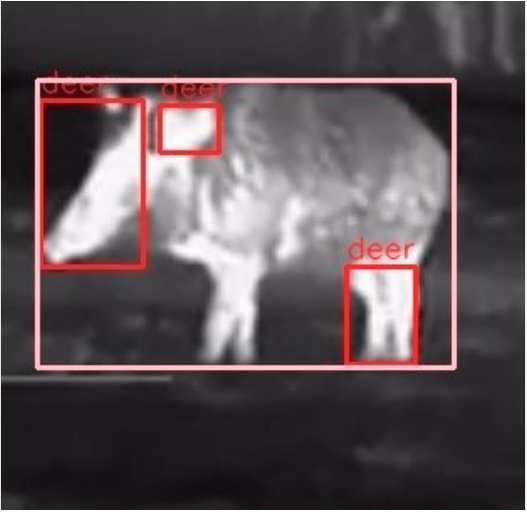
Figure 6. Lack of detection result using HOG/SVM—the algorithm found only most bright parts of the animal.